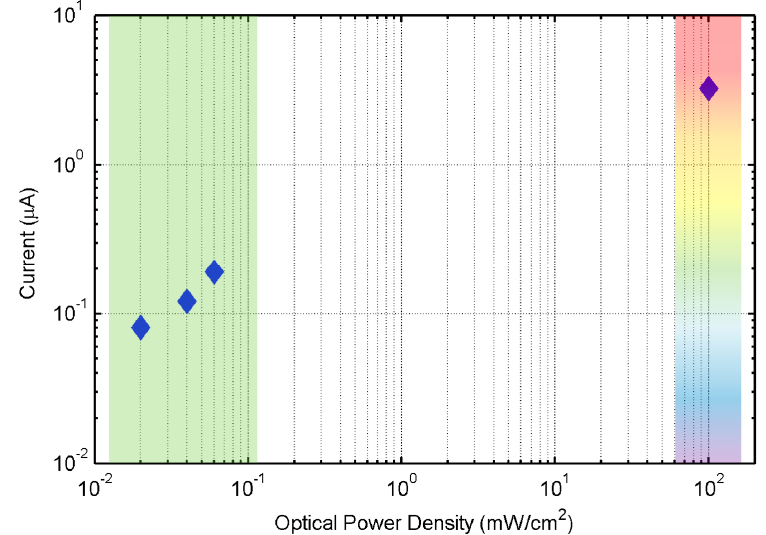
Figure 8. Optical power density vs. photocurrent.